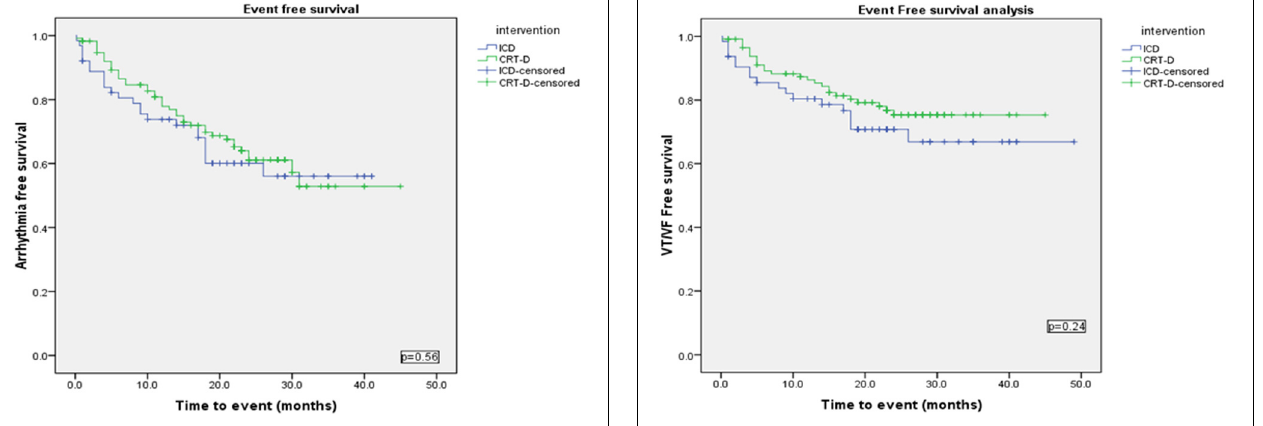
FIGURE 5 | Kaplan Meyer survival analysis of the occurrence of VT/VF between ICD and CRT-D